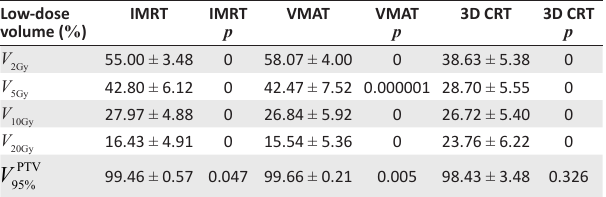
TABLE 5: Low-dose volumes. Low-dose volume ( % )